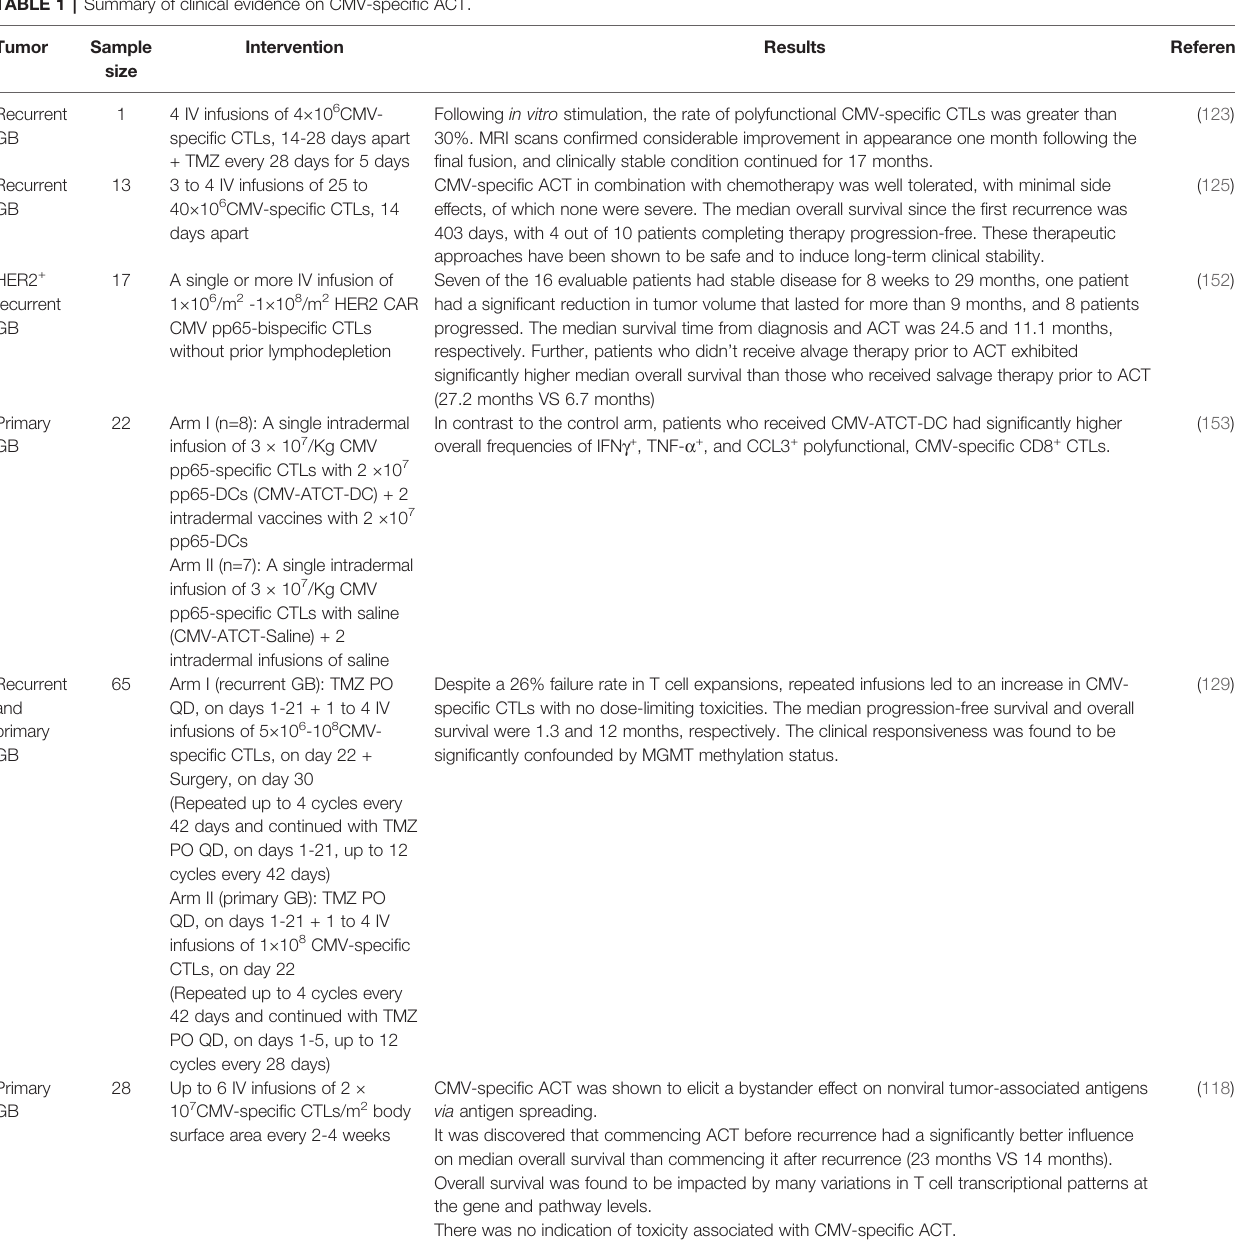
TABLE 1 | Summary of clinical evidence on CMV-speci fi c